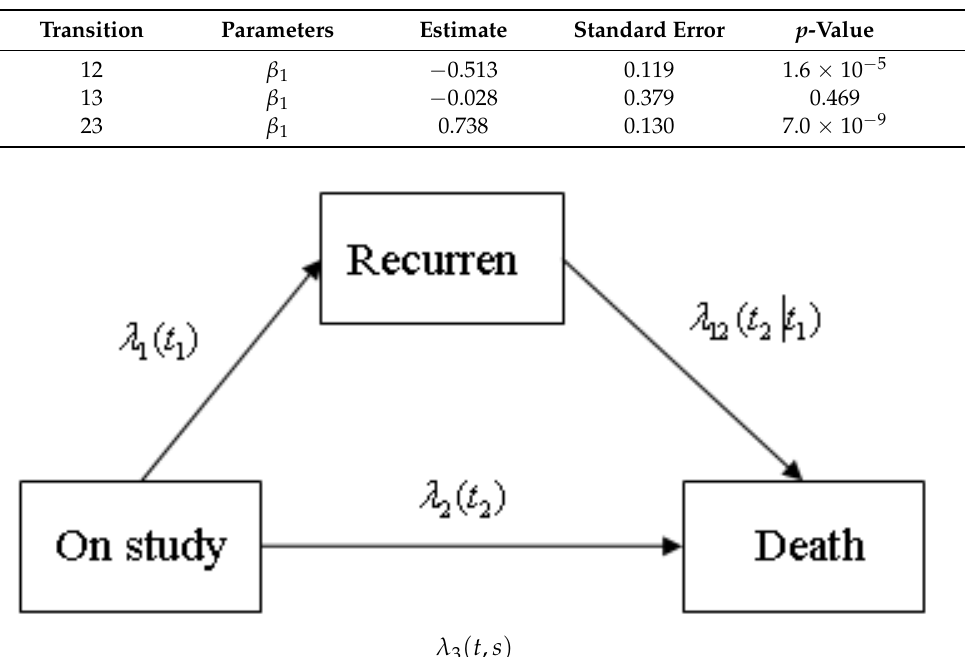
Table 4. Estimated regression coefficients and their standard errors for the colon data.